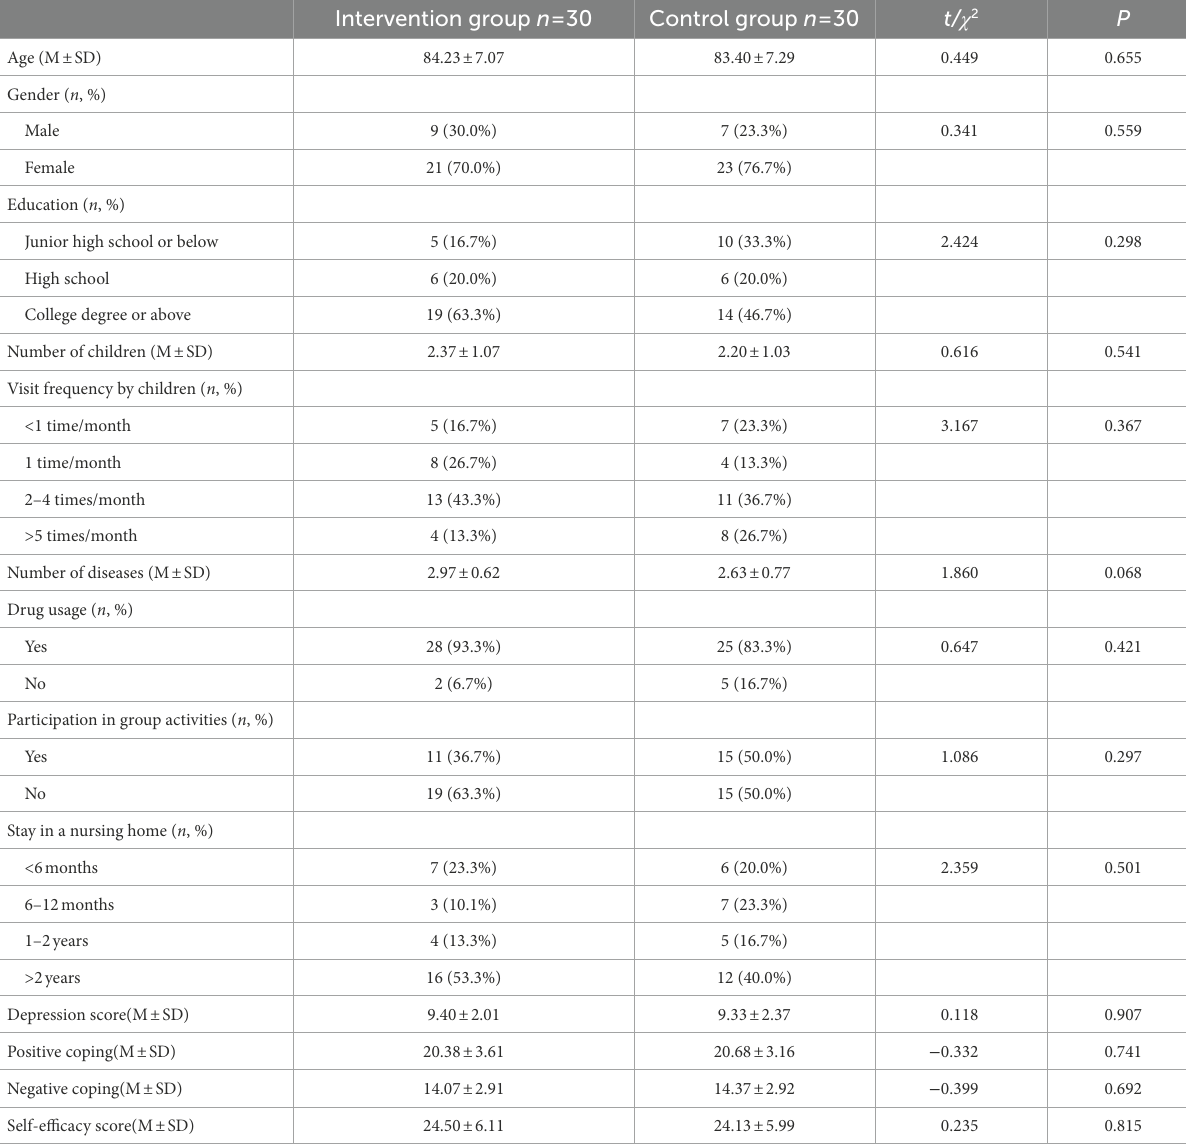
TABLE 2 Baseline characteristics of participants.